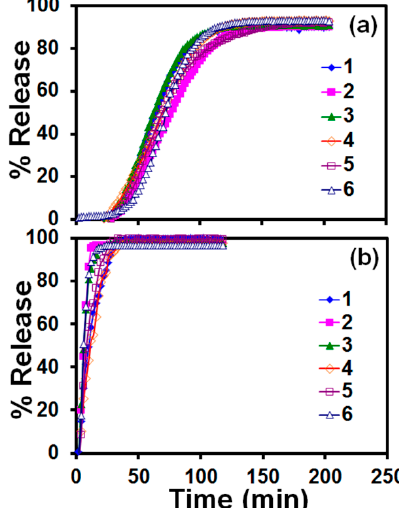
Figure 8. Release profiles of griseofulvin from ( a ) six porous (20.4 ± 0.4) -mg HPMC films, each loaded with 25 µL of 2.5% HPMC-griseofulvin suspension by printing fifty 0.5-µL droplets, and ( b ) six 25-µL specimens of the same griseofulvin suspension.